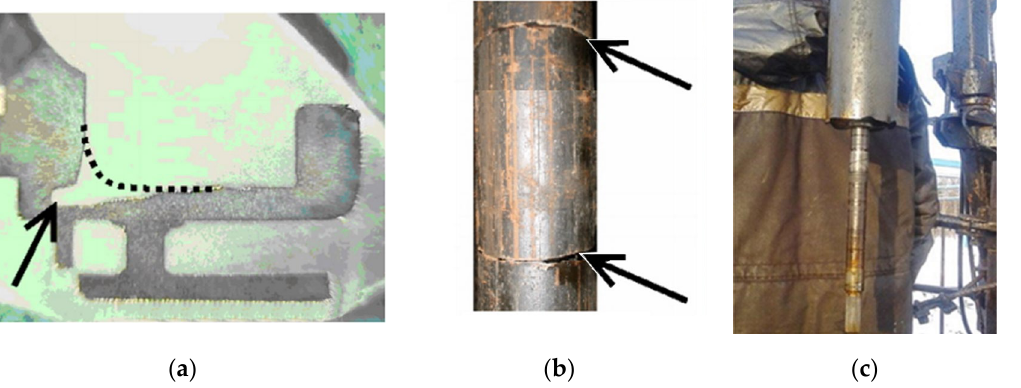
Figure 1. Hydroabrasive wear of the guide vanes ( a ) (the arrow points to areas of local hydroabrasive wear of the ESP guide apparatus, the dotted line shows its original cross-sectional shape) and the consequences of cutting the housings of electric submersible pumps ( b , c ) (arrows show the consequences of hydro-abrasion—cutting of the ESP housing).